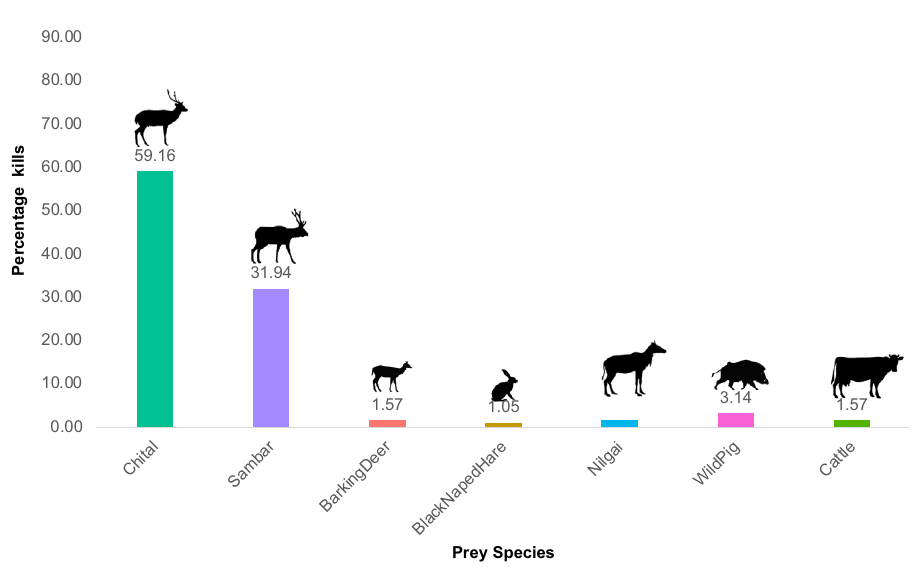
Figure 3. Proportion of prey species in dhole diet based on overall kill observations of all species in field from two study sites (TATR and NNTR).